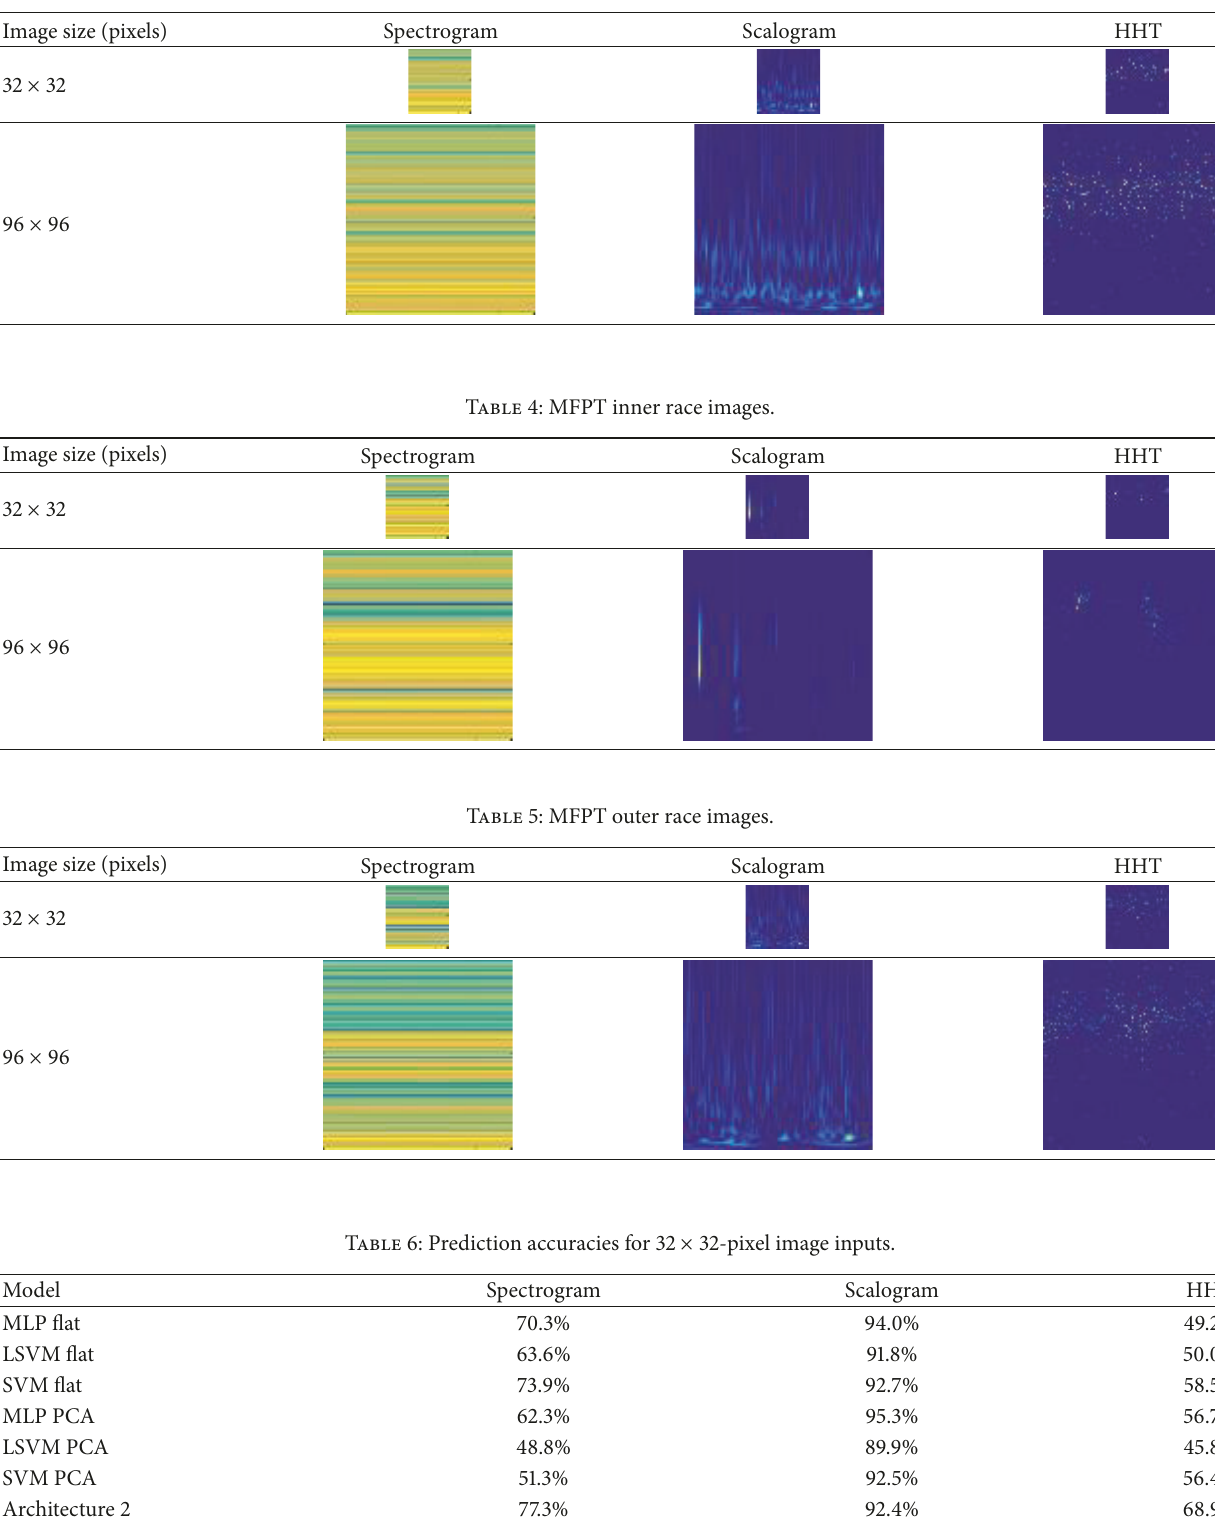
Table 3: MFPT baseline images.